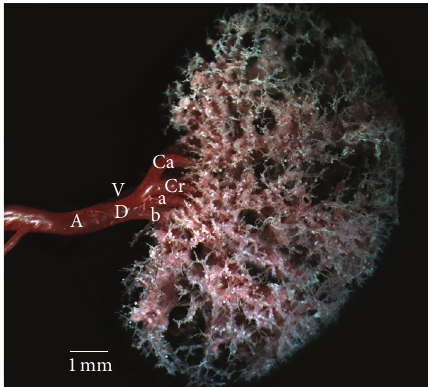
Figure4:Dorsalviewoftheintrarenalbranchesoftherenalarteries, Type Ic. A: renal artery; V: the ventral branch of renal artery; D: the dorsal branch of renal artery; Cr: the cranial division of the renal artery; Ca: the caudal division of the renal artery; a: first interlobar branchfromtherenalarteryforthecranialpole;b:secondinterlobar branch from the renal artery for the cranial pole.